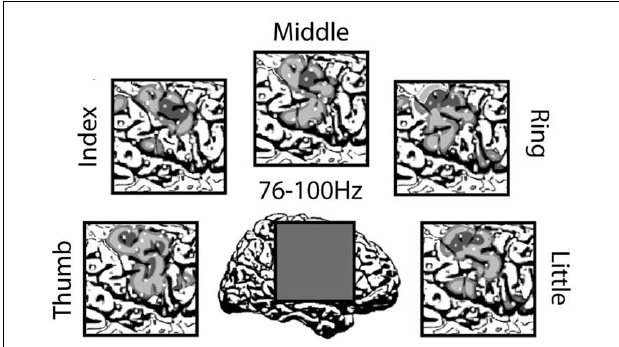
FIGURE 29 | (Data Set 4). A blow-up of the sensorimotor region for high frequencies from Figure 28 . Note that this variability across electrodes allows for robust segregation of different finger movements during classification.